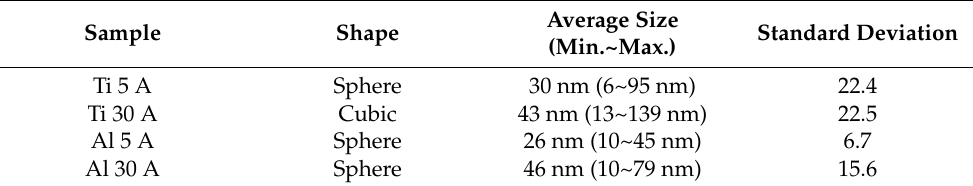
Figure 4. FE-SEM pictures of Ti 5 A and Ti 30 A and corresponding EDS ( a , b ) Ti elemental and ( c , d ) N elemental mapping images. Detailed descriptions are placed below each panel. Table 2. Morphology and average particle size of prepared fine